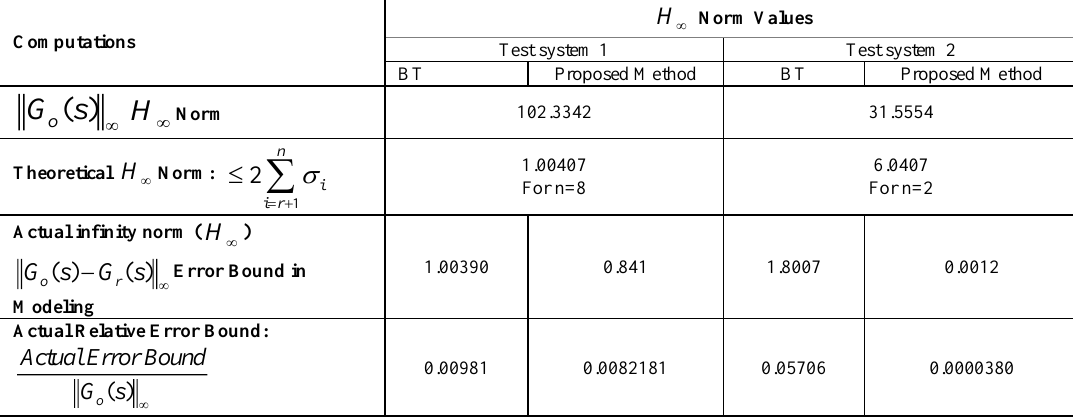
Table 1. Error bound for different reduction methods for test